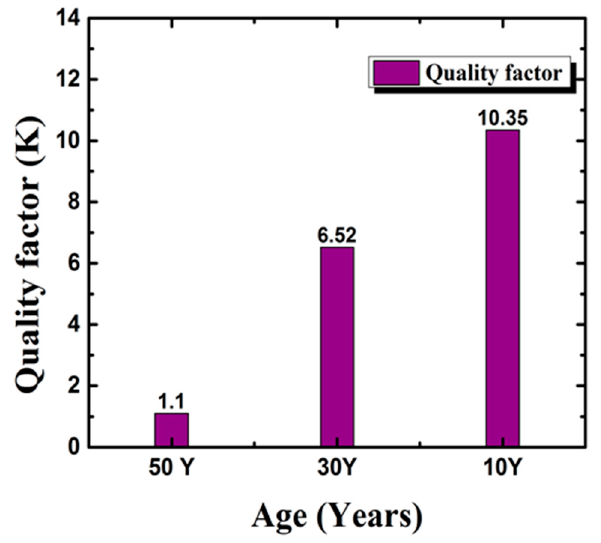
Figure 4. Quality factor calculated based on load test on porcelain insulators.